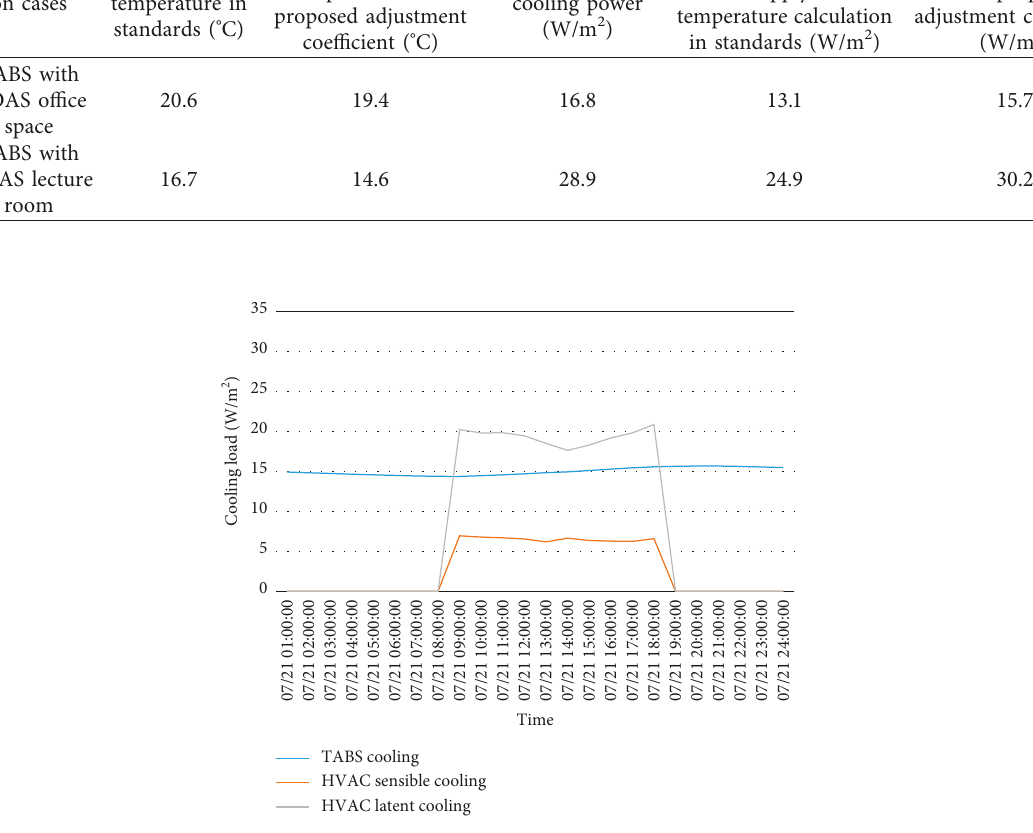
Figure 18: Amount of TABS and DOAS cooling in the office space with the proposed method.